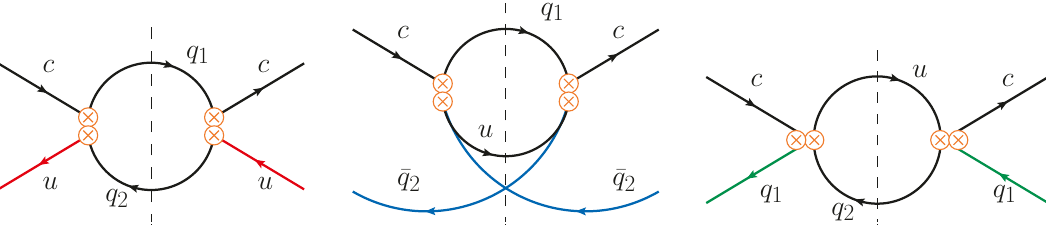
Figure 5 . Spectator quark effects in the HQE expansion: WE (left), PI (middle) and WA (right).